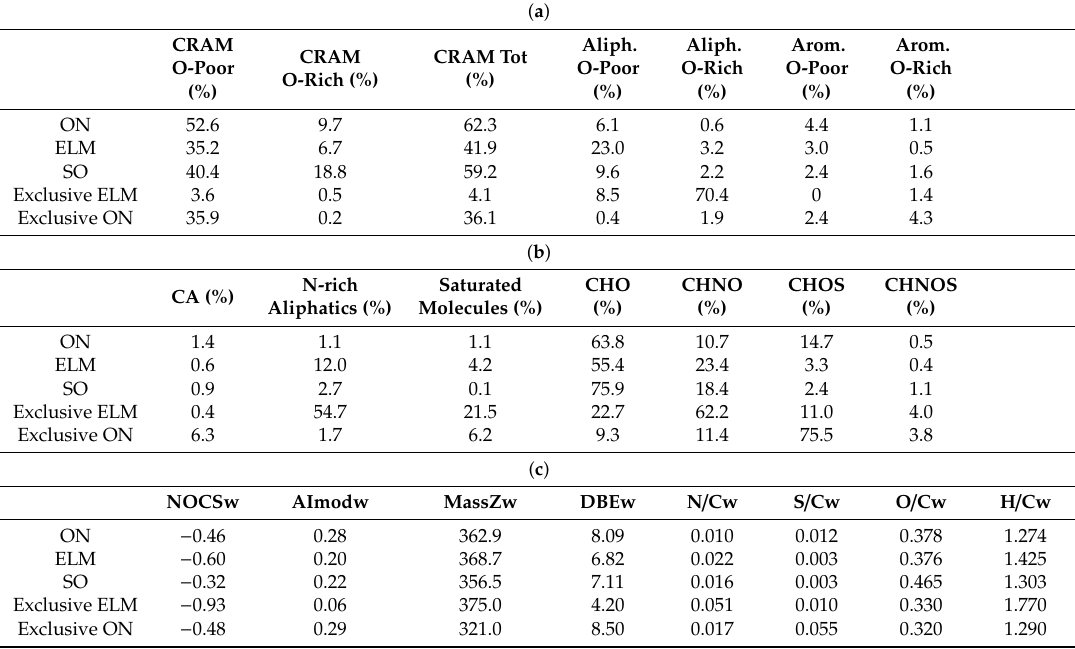
Table 4. Molecular characterization of SPE-DOM from the two hot springs (ON, ELM) and Lake Sonachi (SO). Molecular class criteria and SPE-DOM descriptors are defined in Table 1. Percentage values are weighted against relative abundance. All the values are signal intensity weighted. CA: condensed and